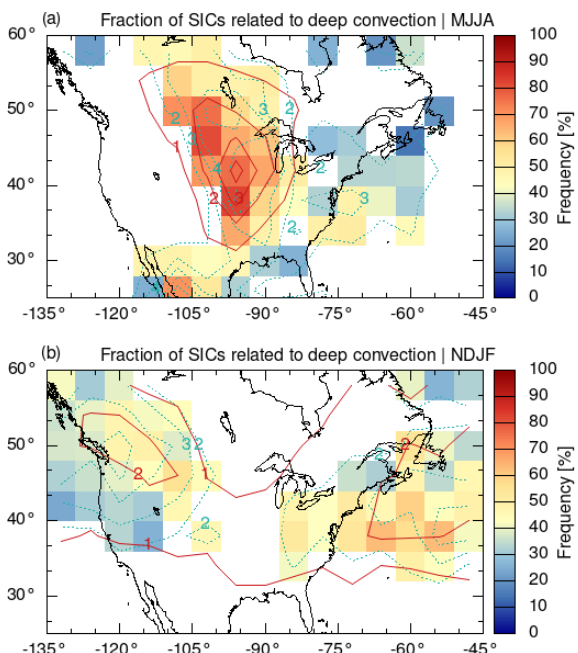
Figure 9. Fraction of SICs related to deep convection with a larger search radius of 6 ◦ × 8 ◦ (latitude × longitude) for deep-convection detection. The red contour lines are the occurrence frequencies of deep convection, and blue dotted contour lines are the occurrence frequencies of